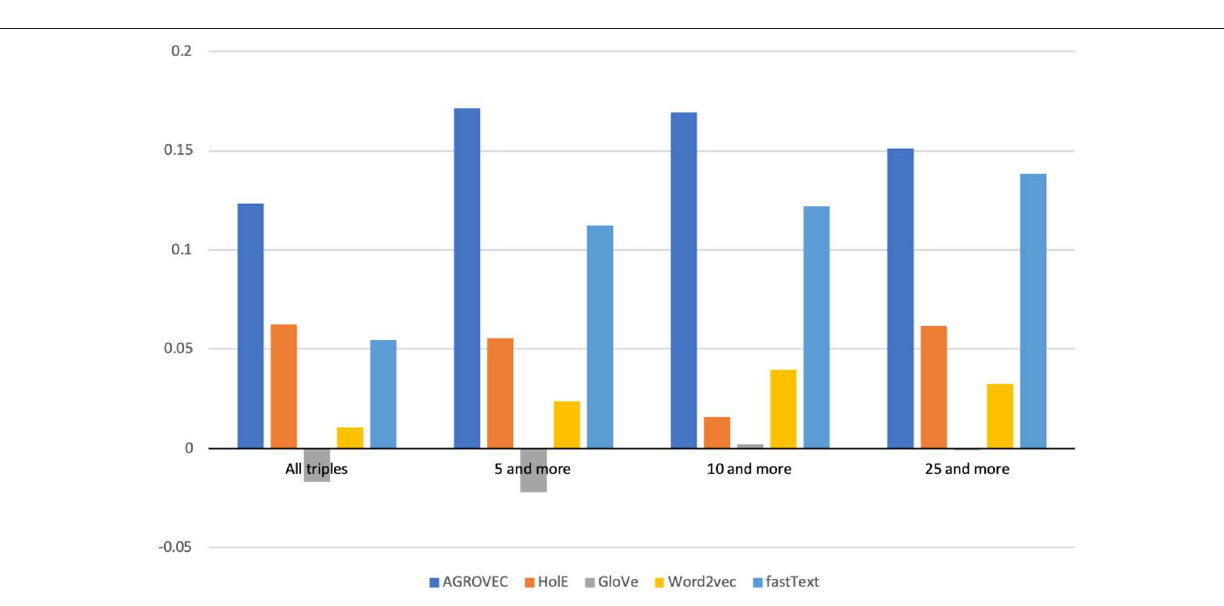
FIGURE 4 | Spearman correlation coefficient scores when evaluated on all triples and relations with minimum number of word pairs in each relation being 5, 10, and